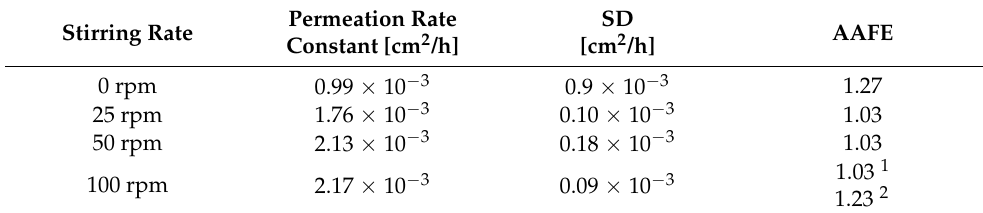
Table 5. Permeation rates calculated for diclofenac sodium at different stirring rates. Each calculation is based on 5 vessels and included 5–6 time points ( n = 25 or n =